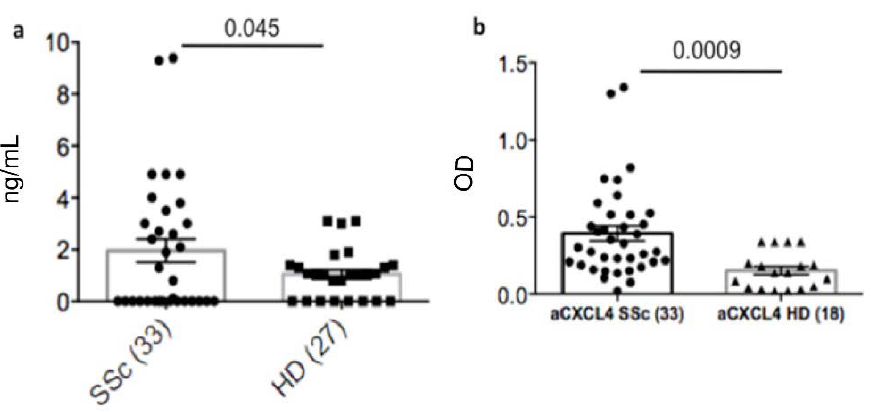
Figure 1. Heparin-dependent anti-CXCL4 antibodies are present in SSc patients. Plasma of SSc patients and HD were tested for the presence of heparin-dependent ( a ) and heparin-independent ( b ) antibodies by using a commercial ( a ) or an in-house ( b ) ELISA [7,8]. Horizontal bars are the means, vertical bars are the standard error of the mean (SEM), p values (indicated in the graphs) were calculated by Student’s t -test for unpaired samples (two tails).